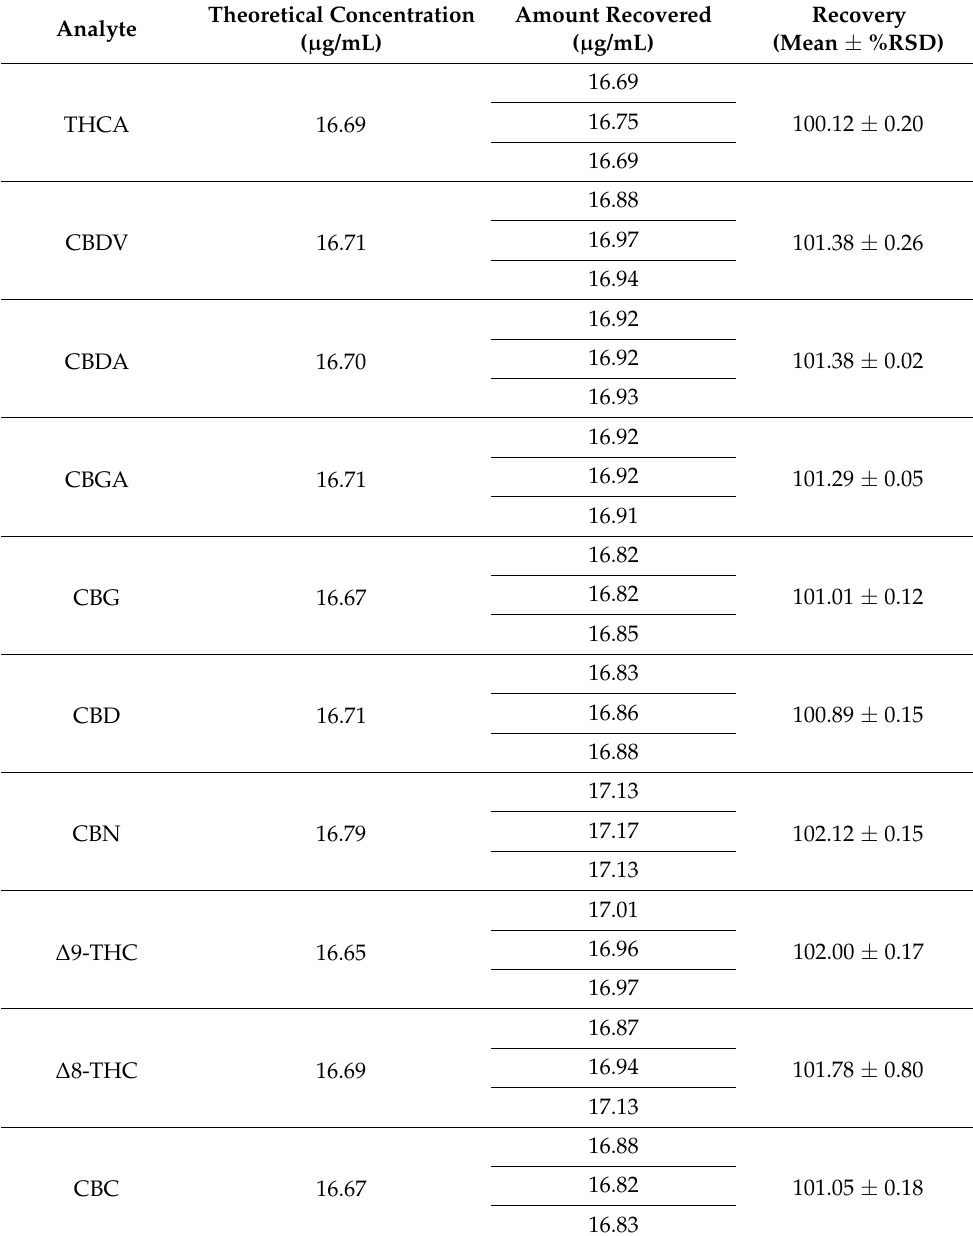
Table 3. Results for